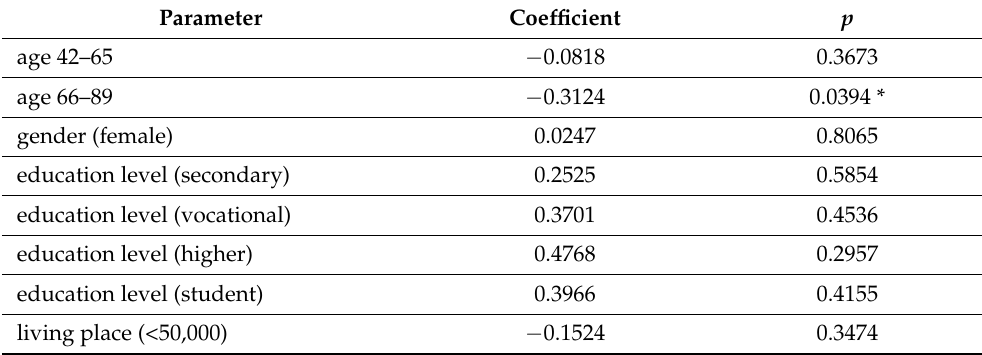
Table 1. Multivariate linear regression analysis of the association between age, gender, education level, living place and changing dietary habits in studied group.